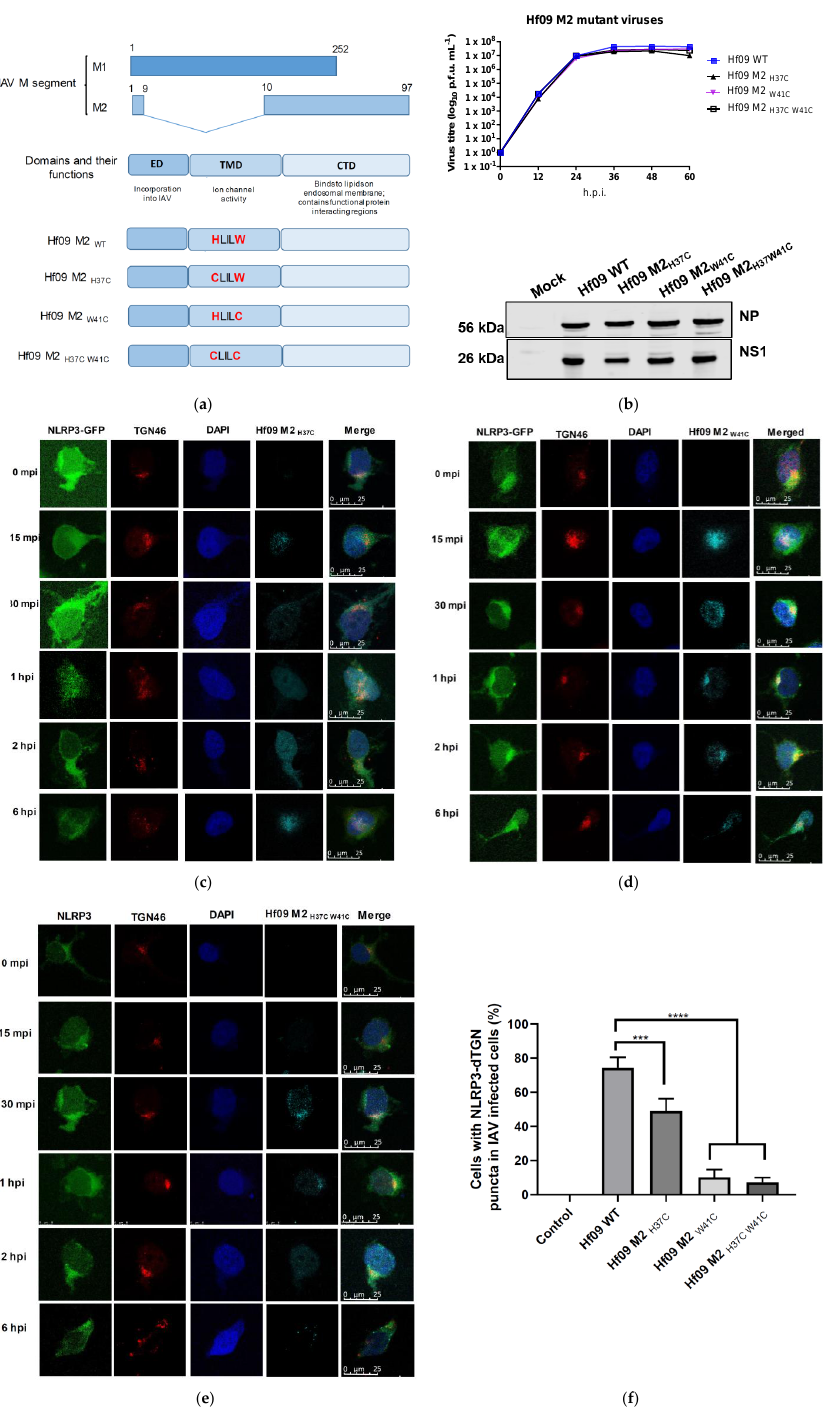
Figure 4. IAV M2 ion channel protein activates NLRP3. ( a ) Schematic representation of M segment- encoded proteins, as well as the mutations made on M2 protein. ( b ) MDCK-M2 cells were infected with WT or one of the M2 defective Hf09 viruses at an MOI of 0.001. The supernatant was collected every 12 h and was subjected to plaque assays to measure the viral titers. Viral protein expression was determined in the infected cells harvested at 36 h.p.i. by Western blotting. Cells expressing NLRP3-GFP were infected with Hf09 M2 H37C ( c ), Hf09 M2 W41C ( d ), or Hf09 M2 H37C-W41C ( e ) at an MOI of 10. At the indicated time points, the cells were fixed and subjected to immunofluorescent microscopy for NLRP3-GFP (green), TGN (red), IAV (cyan), and nucleus (blue). Scale bar, 25 μm. ( f ) The number of cells showing dTGN was counted from 100 IAV-infected cells (1 h.p.i.) in 5 different areas. (two-sided t -test, *** p = 0.0004; **** p < 0.0001).